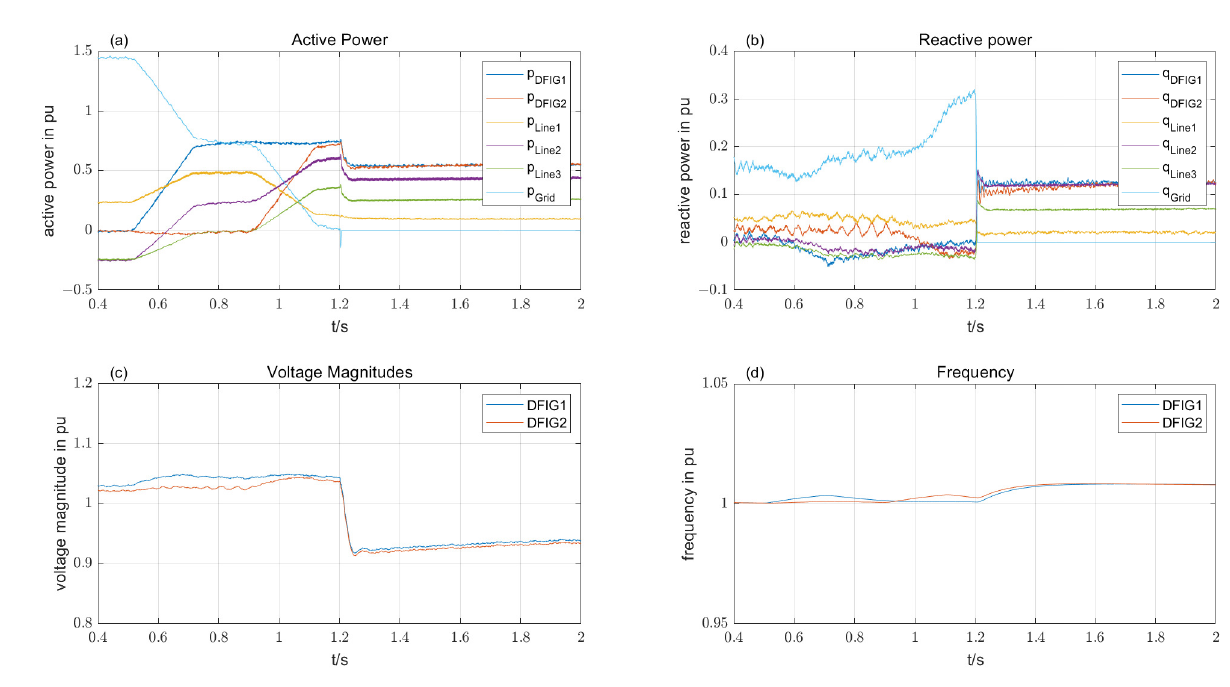
Figure 14. Simulation results of grid-forming operation in a 3-node grid: ( a ) active power. ( b ) reactive power, ( c ) voltage magnitudes and ( d )